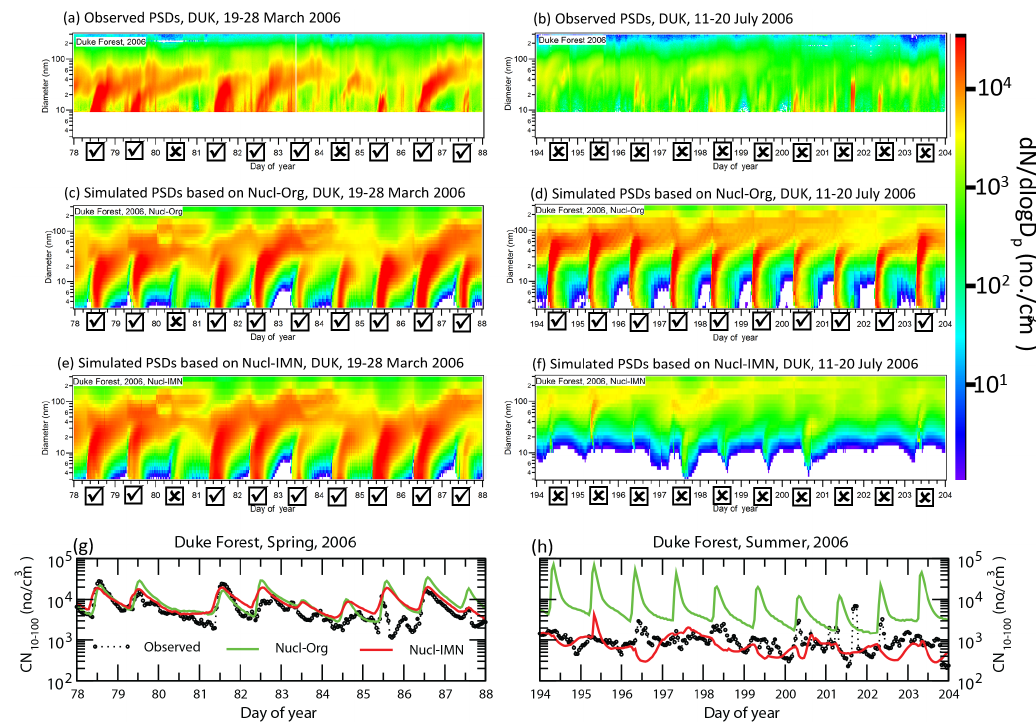
Figure 3. Particle size distributions (PSDs) observed (a, b) and simulated based on Nucl-Org (c, d) and Nucl-IMN (e, f) schemes during two 10-day periods in March (a, c, e) and July (b, d, f) of 2006 in Duke Forest (DUK), along with time series of the concentration of condensation nuclei between 10 and 100nm (CN 10 − 100 ) (g, h) . The event ( (cid:88) ) and non-event ( × ) days determined based on the criterion given in Sect. 2.3 for the observed and simulated PSDs are marked in (a–f)